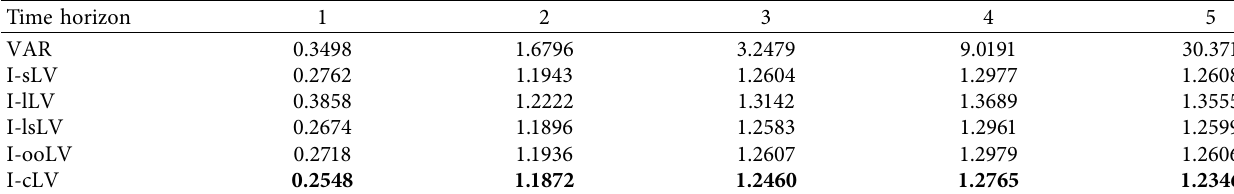
Table 4: Average MAE across all spots for diferent I-LV